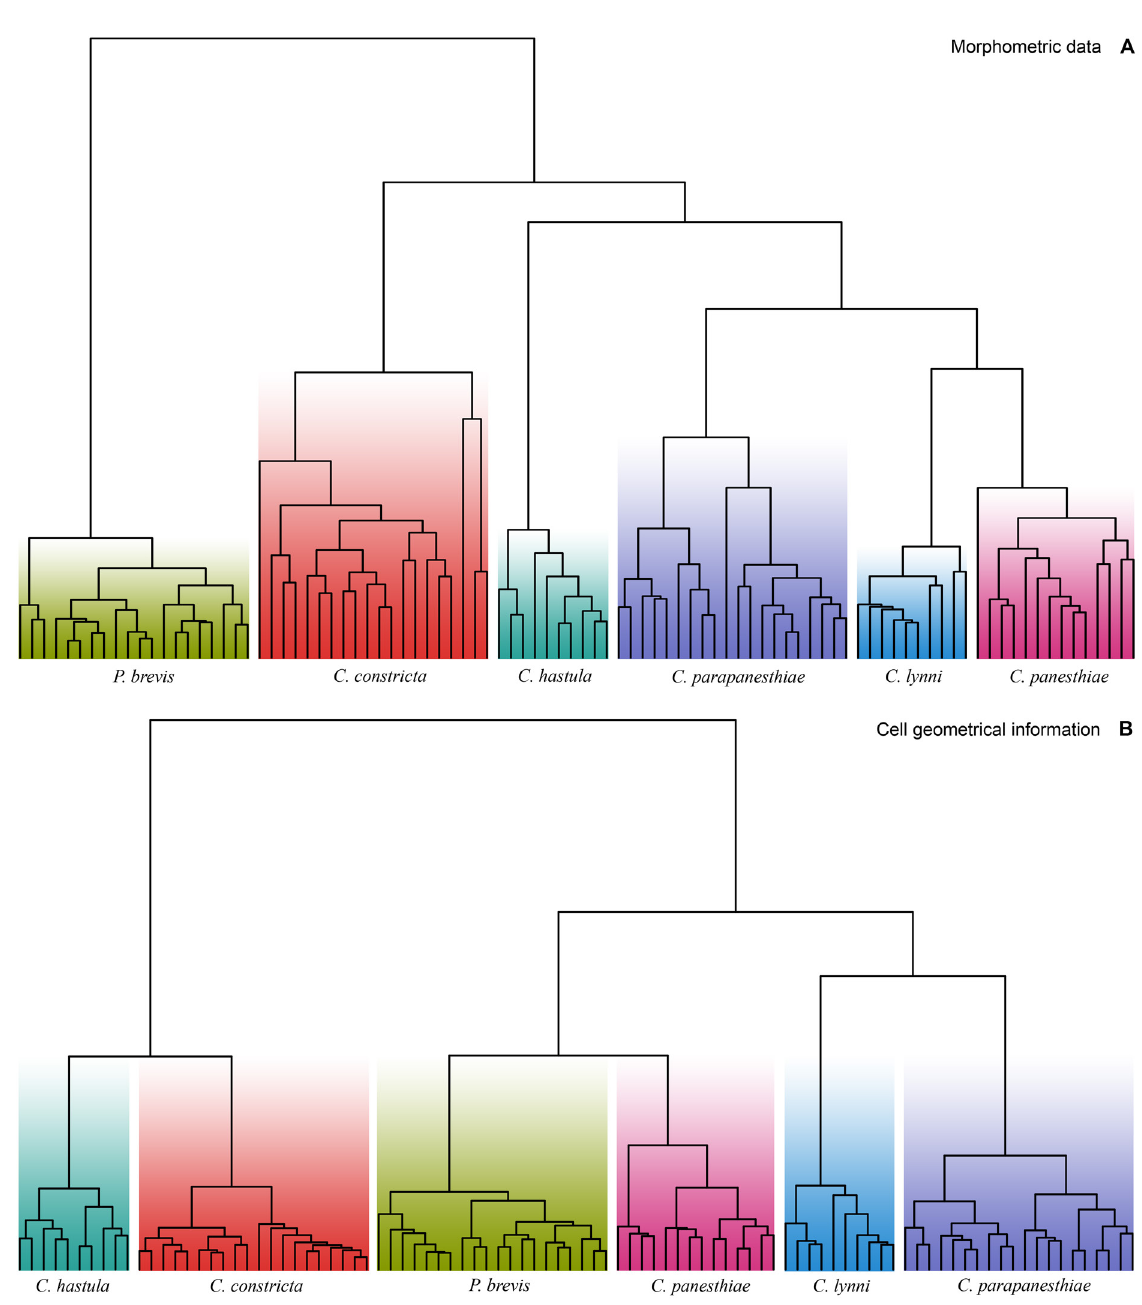
Fig. 15. Cluster analyses of 94 specimens of six clevelandellid morphospecies based on morphometric data (A) and the cell shape information (B). A . Weighted average linkage clustering method in a combination with Gower’s similarity index. B . Ward’s D2 clustering method in a combination with the Manhattan city block distance. The morphometric and geometrical data delimit the clevelandellid morphospecies consistently and unambiguously, i.e., each clevelandellid morphospecies forms a homogeneous cluster that is well isolated from all other morphospecies analyzed. Since both techniques are phenetic, their results refer only to the similarity of the analyzed morphospecies in phenotypic space and not to their relatedness. Members of each morphospecies are highlighted by the same